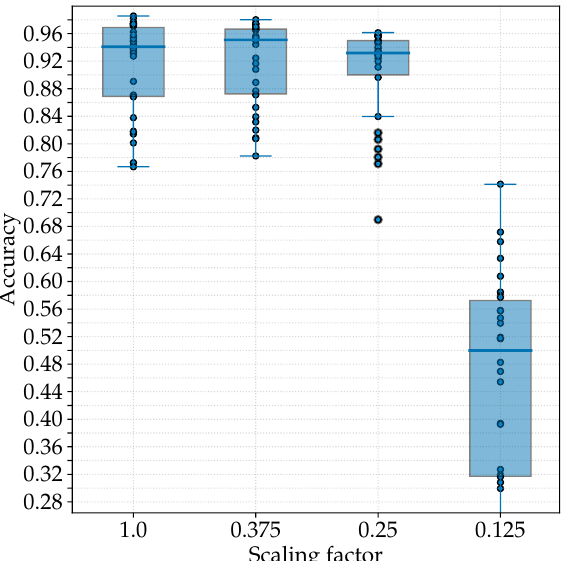
Figure 6. Boxplots depicting the test accuracy of networks with different scaling factors of the image patch to be inserted. The x -axis is not proportional. Network input size, network size and number of parameters are identical for every